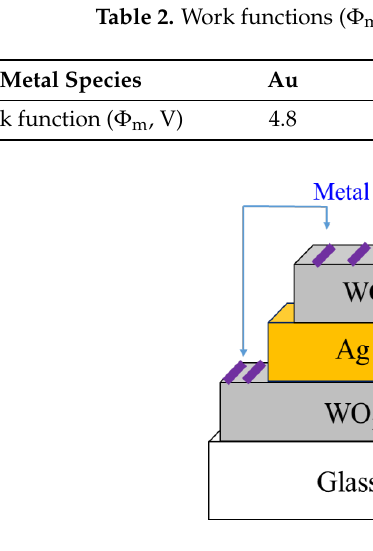
Figure 5. Schematic diagram of band diagram of WO 3 film as an n-type semiconductor.